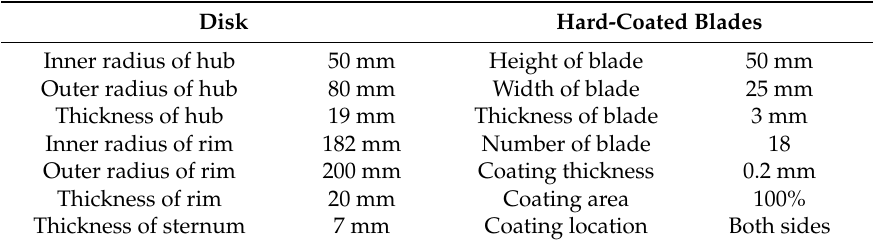
Table 1. Geometrical parameters of the mistuned blisk and hard coating.